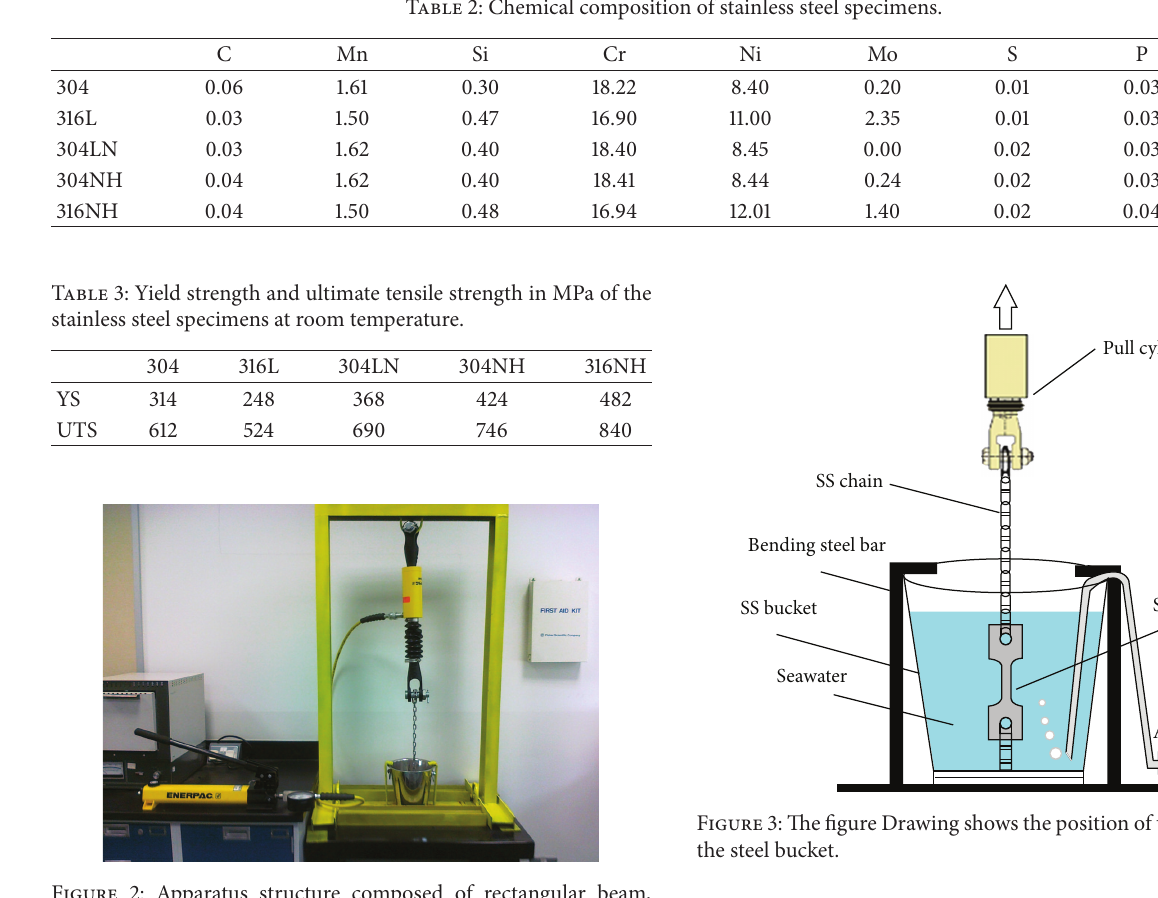
Figure 2: Apparatus structure composed of rectangular beam, hydraulic hand pump, pull cylinder, and stainless steel bucket.